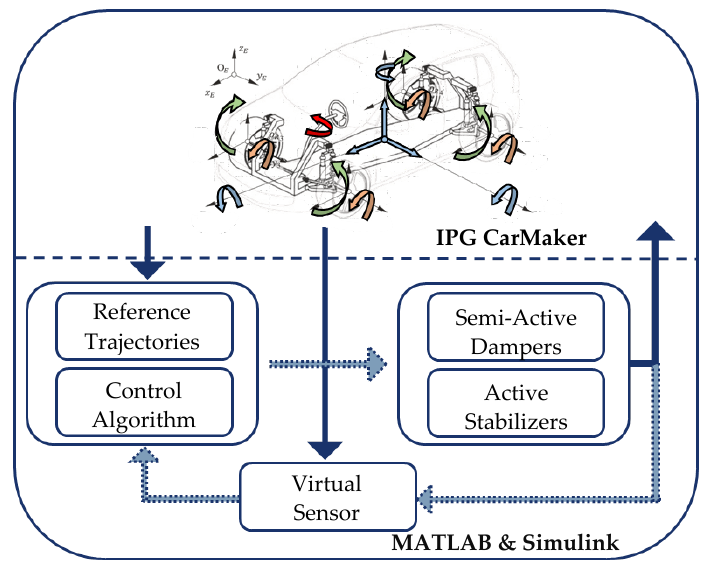
Figure 1. Simulation Framework, cf. [15].